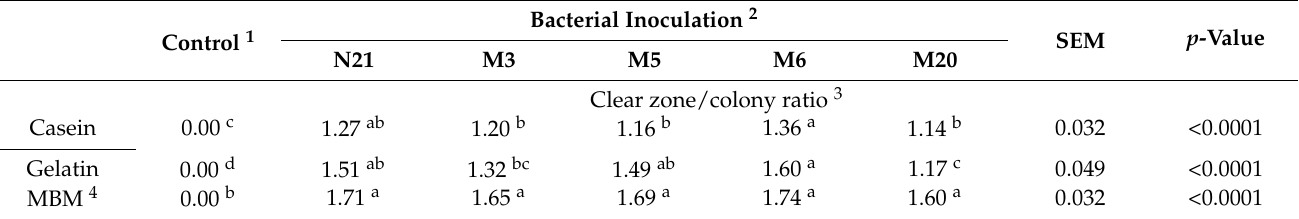
Table 3. Characteristics of proteolytic activity from different Bacillus strains.